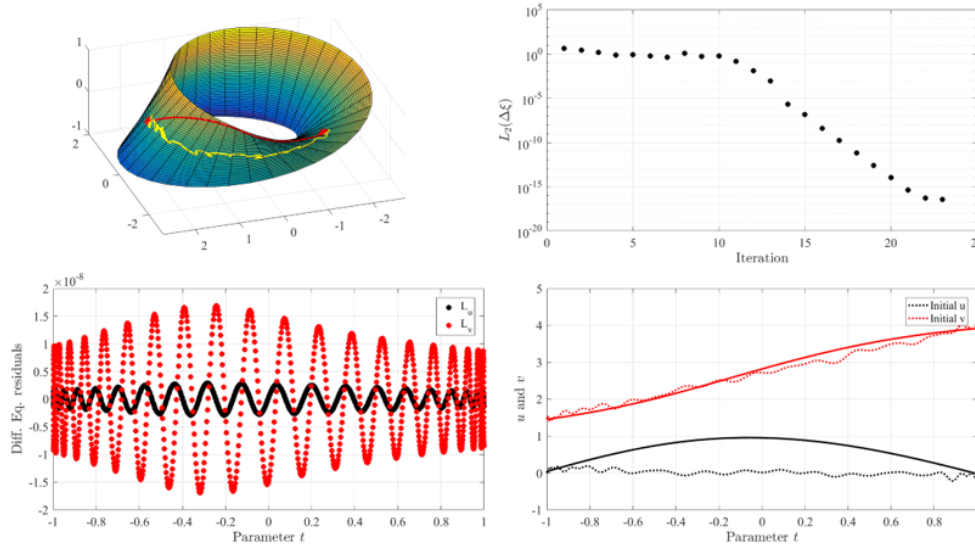
Figure 9. Moëbius strip test